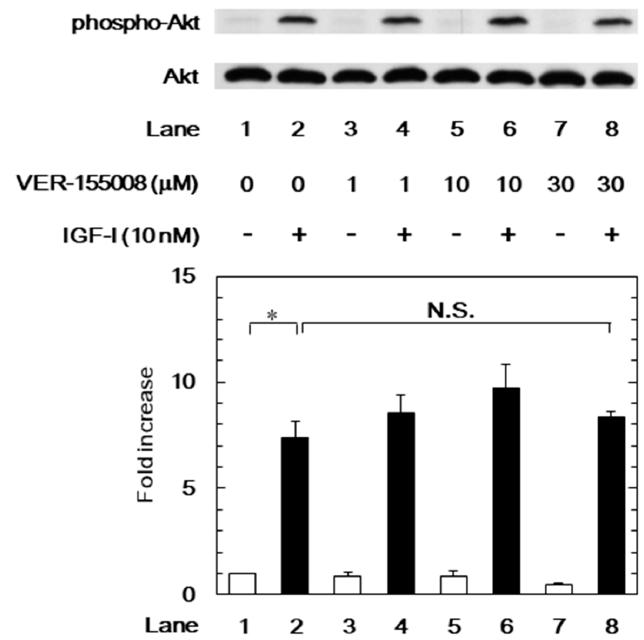
Figure 5. Effect of VER-155008 on the IGF-I-induced p44/p42 MAP kinase phosphorylation in MC3T3-E1 cells. The cells were pretreated with various doses of VER-155008 for 60 min and then stimulated by 10 nM of IGF-I or vehicle for 5 min. Western blot analysis was performed using phospho-specific p44/p42 MAP kinase or p44/p42 MAP kinase antibodies. The histogram shows quantitative representation of the levels of IGF-I-induced phosphorylation obtained from a laser densitometric analysis of three independent cell cultures. The white and black bars indicate IGF ( − ) and IGF (+), respectively. * p < 0.05 compared to the value of the control cells without IGF-I stimulation. ** p < 0.05 compared to the value of IGF-I alone.